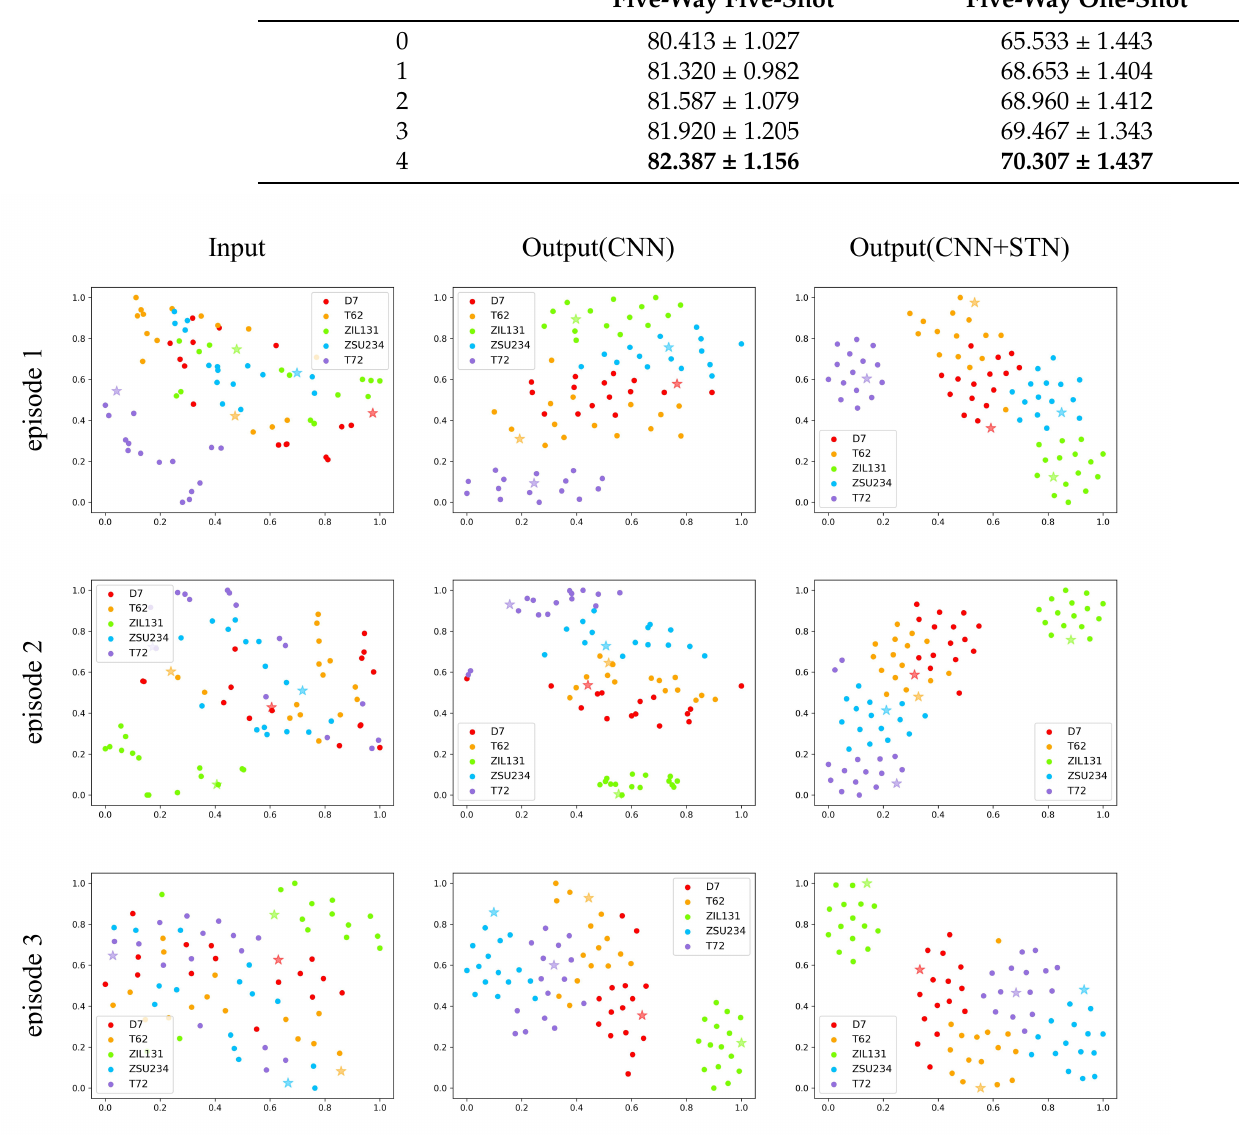
Figure 7. T-SNE visualization results of the whole stages of three individual episodes for five-way one-shot experiments. Each column denotes a stage and each row denotes an episode. Images in the left column indicate visualization results of input, outputs of CNN in the middle, and outputs of STN cascaded after CNN on the right. Note that each solid circle and star of the same color stands for the same